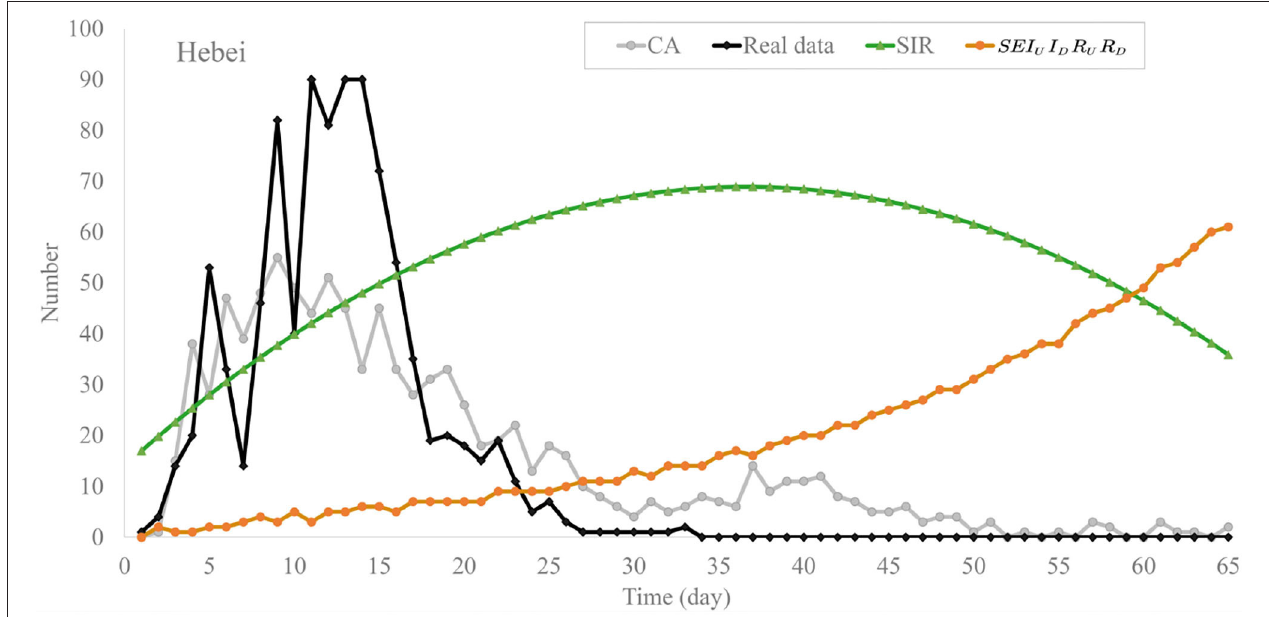
FIGURE 8 | Trend chart of daily confirmed cases of the models in Hebei